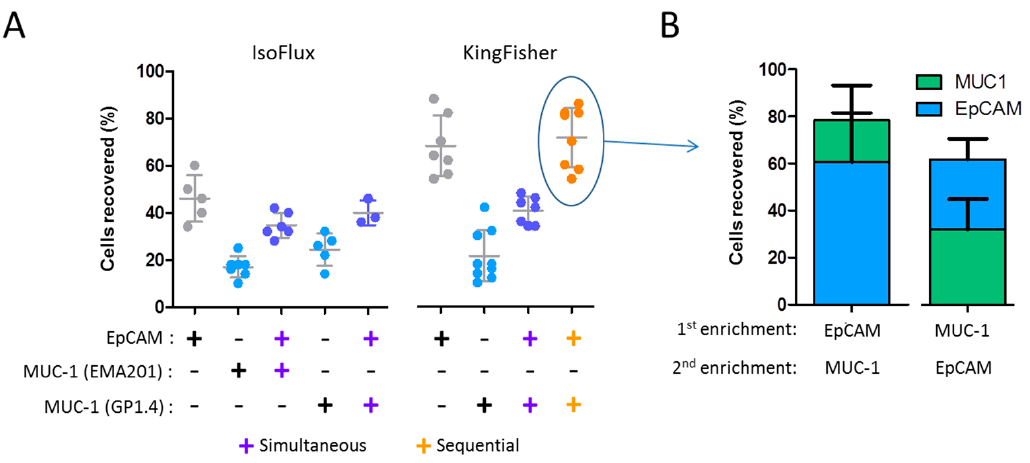
Figure 4. MUC-1 alone and MUC-1 / EpCAM combined recovery of CAPAN-1 cells spiked in mimicked-DLA products. ( A ) (Left panel) Recovery of 50 pre-labeled CAPAN-1 cells with Iso-RCEK beads coupled with anti-MUC-1 clones EMA201 and GP1.4 alone or in combination (simultaneous) with anti-EpCAM coupled beads using the IsoFlux system. For the simultaneous MUC-1 and EpCAM recovery, half of the amount of each bead type was used, so that the total amount of beads in the experiment was according to the original protocol. Data in grey are the same as in Figure 2. (Right panel) Recovery of 50 pre-labeled CAPAN-1 cells with Dy-BioB beads coupled with the GP1.4 clone alone or in combination (simultaneously and sequentially) with Dy-BioB anti-EpCAM coupled beads using the KingFisher Duo system. For the simultaneous MUC-1 and EpCAM recovery, half of the amount of each bead type was used, so that the total amount of beads in the experiment was the same as described in the material and methods (Dy-BioB MAX ). Data in grey are the same as in Figure 2. ( B ) Recovery of 50 pre-labeled CAPAN-1 cells after sequential EpCAM- and MUC-1-based enrichment in the KingFisher system.